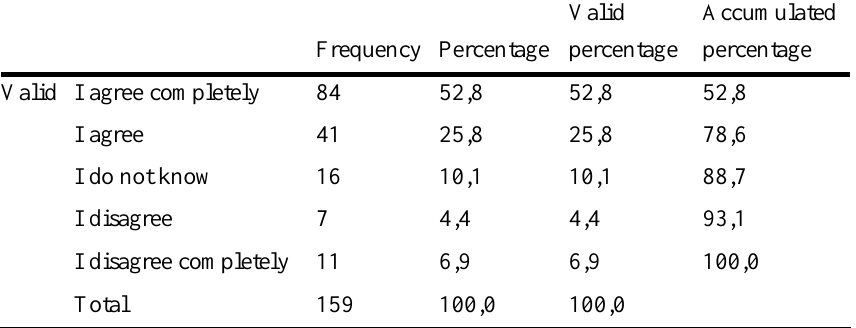
Valid percentage questionnaires´ results, question 7 “Learning science subjects through English is beneficial for